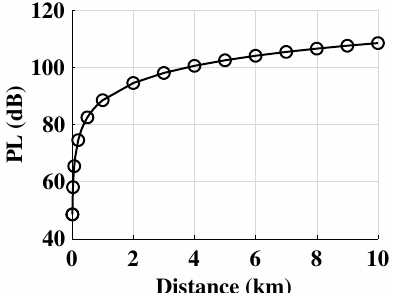
Figure 4. The path loss with change in